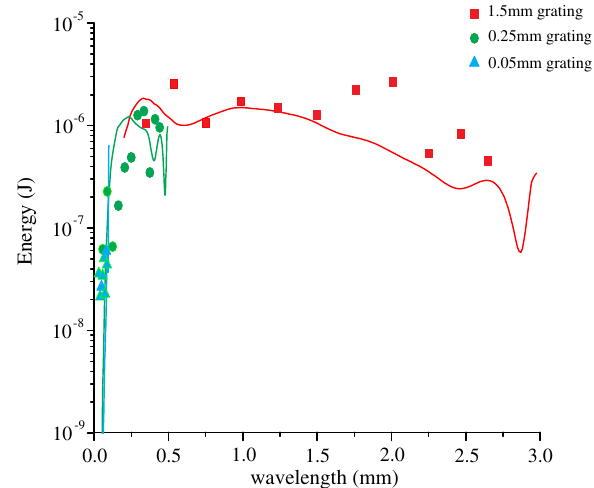
FIG. 9. The measured spectral yield for the run of Fig. 7. The solid lines are the expected yields from each of the three gratings, assuming that the bunch profile is the one shown in Fig.